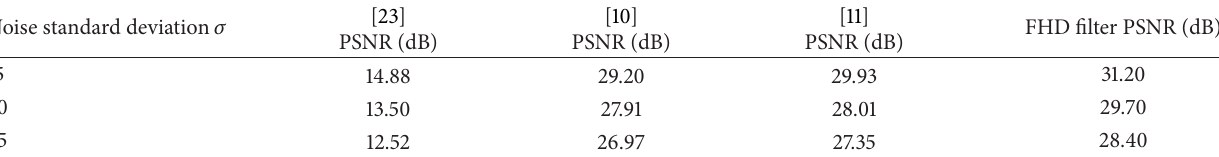
Table 2: Comparison of the experimental results for the standard image “Boat” with other